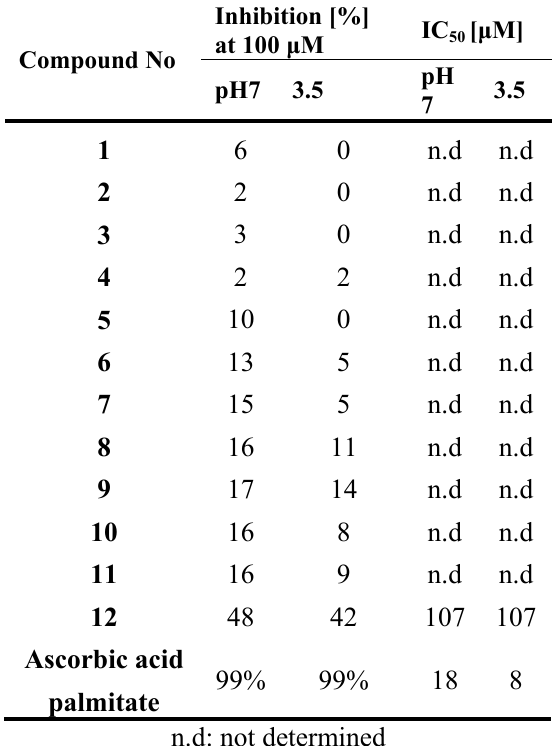
Table 3 . The effects of the synthesized compounds on hyaluronidase activities at different pH